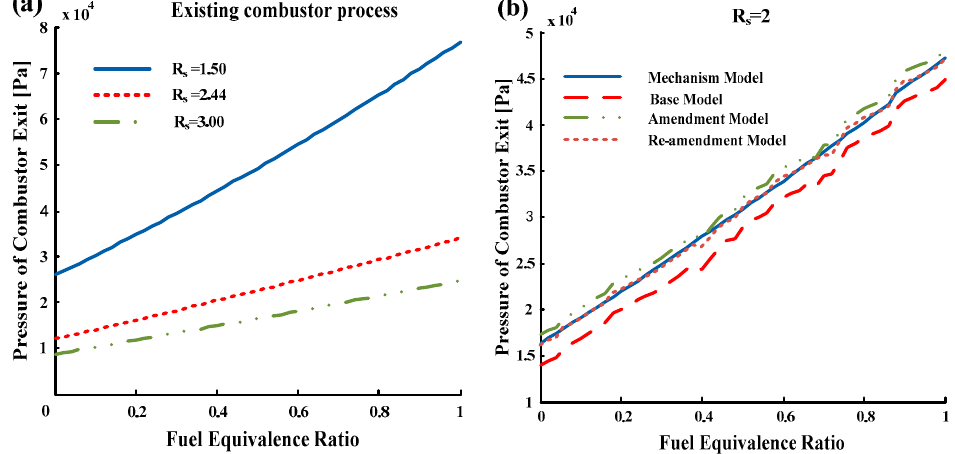
Figure 4. Simulation of the total pressure of the outflow fluid with 50 data pairs. ( a ) existing combustors; ( b ) simulation of the new